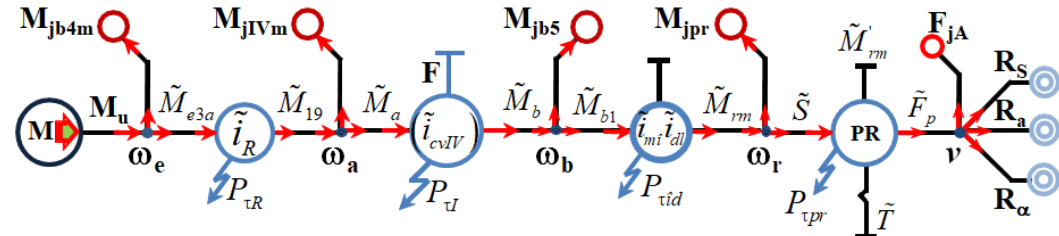
Figure 4. Generalized nodal scheme of a vehicle on tracks in the case of hydromechanical operation.